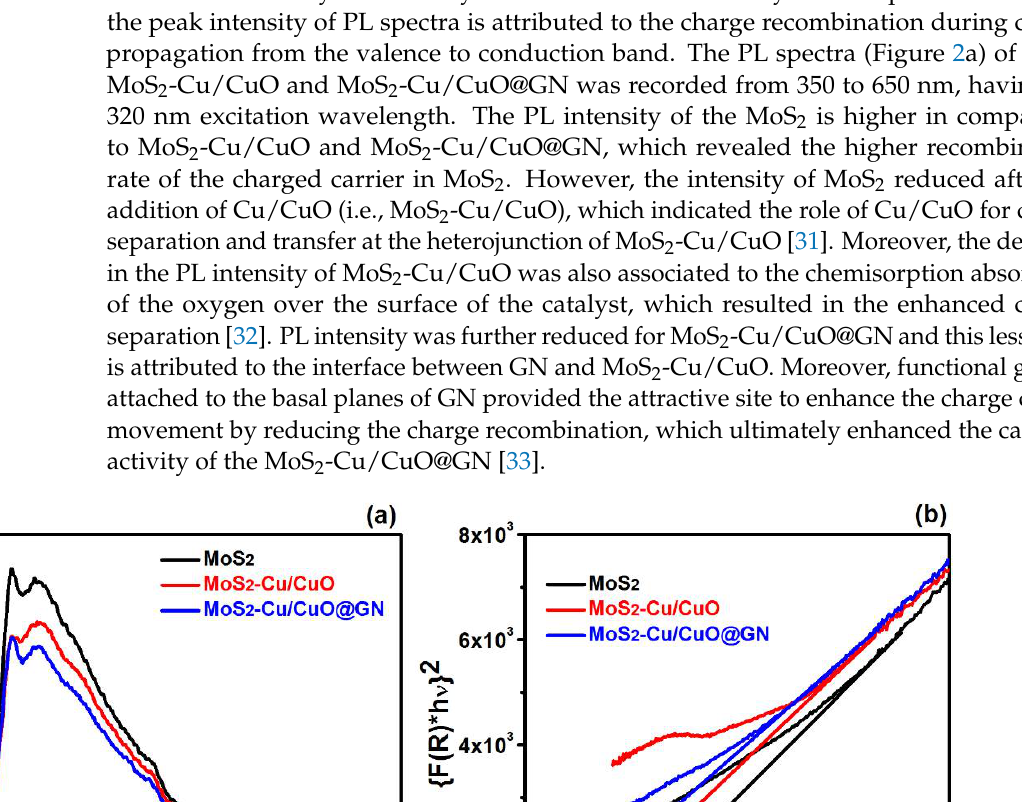
Table 1. Calculated structural parameters for MoS 2 , MoS 2 -Cu/CuO and MoS 2 -Cu/CuO@GN.